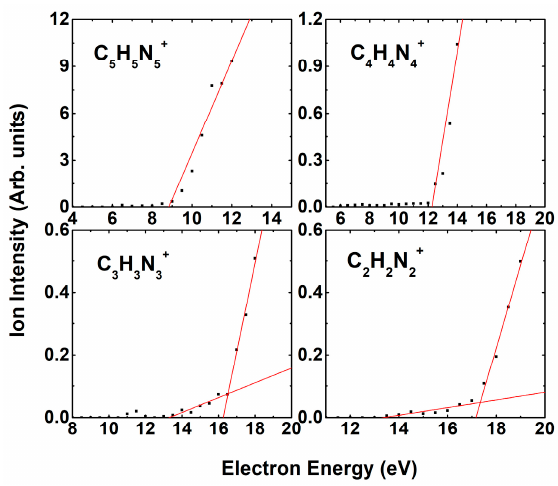
Figure 1. Appearance energies for some major fragment ions from adenine. Table 2. Appearance energies of major ions from adenine in eV.